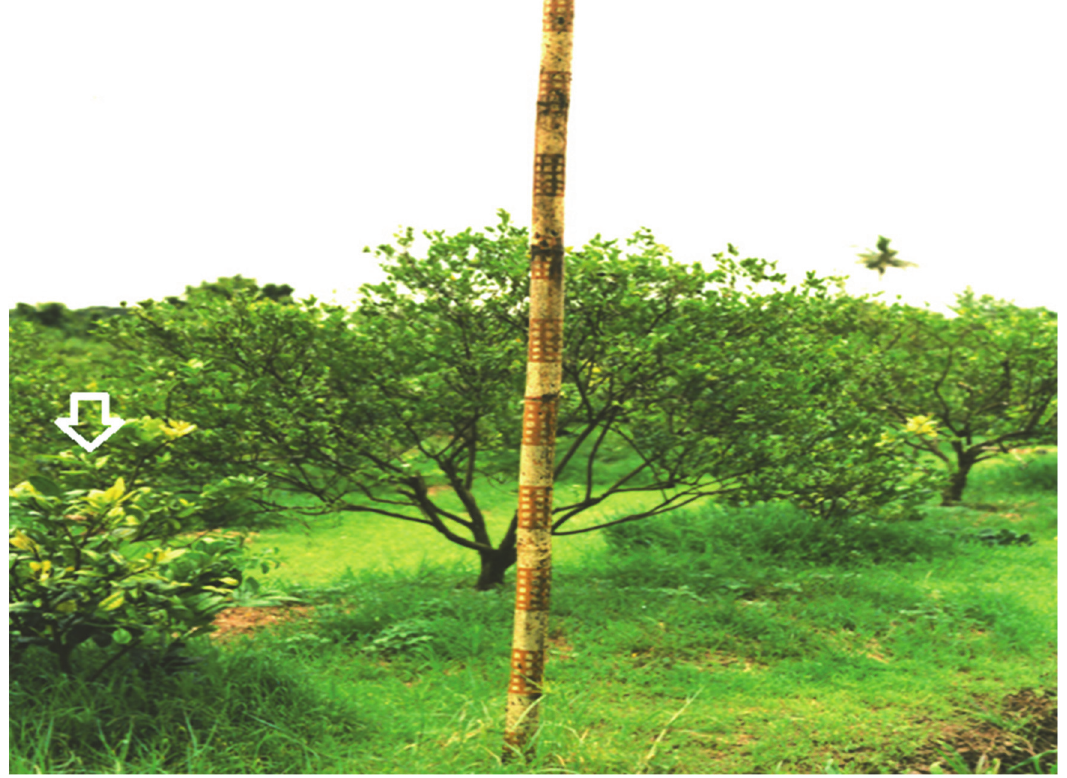
Figure 2. A bamboo pole trap used in the trapping of adult Asian citrus psyllid in an HLB ‐ infected citrus orchard; an HLB ‐ infected citrus tree showing yellow shoot symptom (arrow).